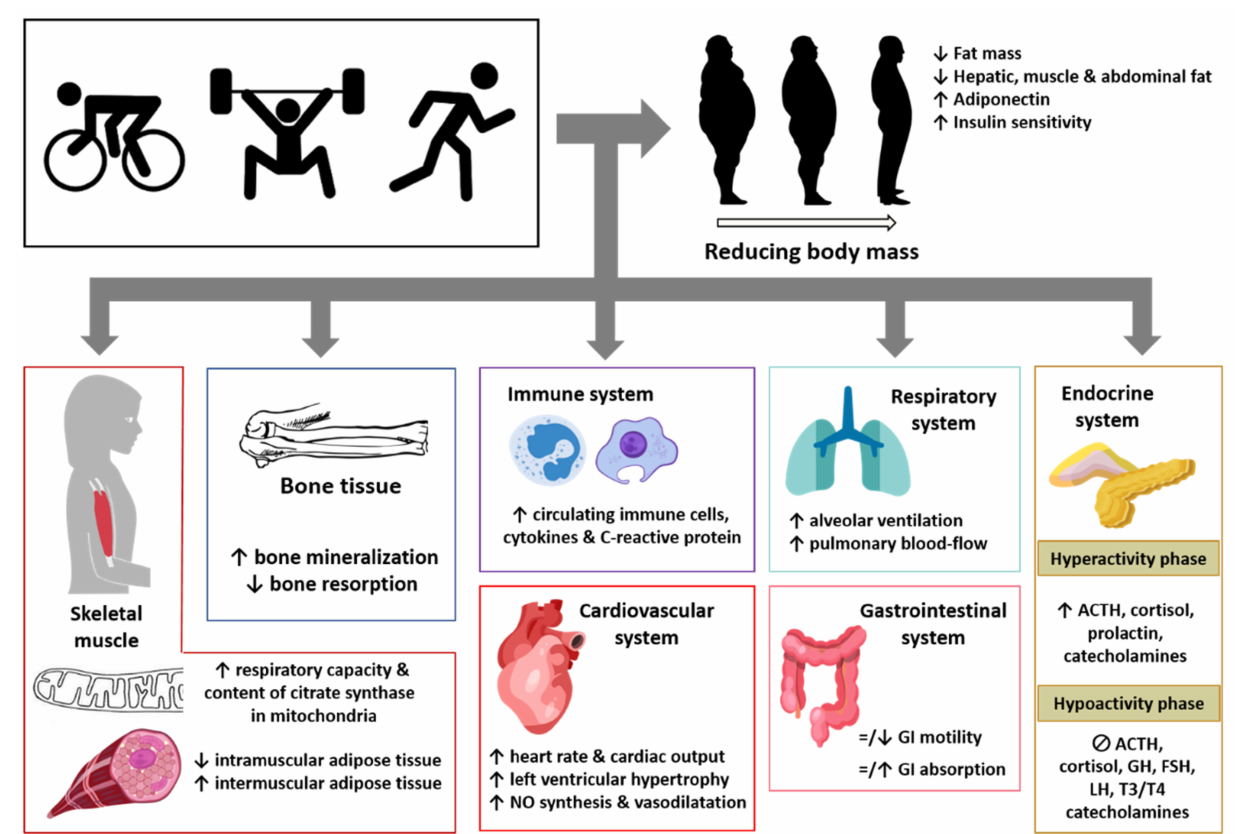
Figure 3. Overall vision of the effect of physical exercise on body tissues and systems. Physical exercise causes a reduction in body mass with a direct impact on the reduction of accumulated fat, which facilitates an increase in the secretion of adipokines that favor tissue insulin sensitivity in obese subjects. Likewise, physical exercise also has a direct impact on various organs and body systems. On skeletal muscle, it causes metabolic changes especially in mitochondrial physiology, increasing respiratory capacity and the content of Krebs cycle enzymes (e.g., citrate synthase). It also causes a decrease in intracellular lipids, favoring adipose tissue to accumulate mainly at the extracellular level, that is, between skeletal muscle fibers (intermuscular adipose tissue). In bone tissue, physical exercise favors mineralization and therefore reduces bone resorption. At the level of the immune system, physical exercise favors an increase in immune cells in the bloodstream, but also in cytokines and proteins of the acute inflammatory phase (e.g.,). In the cardiovascular system, physical exercise improves various cardiac parameters, and favors the release of diffusible factors that induce vasodilation. On the respiratory– pulmonary system, physical exercise increases alveolar ventilation and pulmonary blood flow. The impact of physical exercise on the gastrointestinal system is dependent on the intensity of this physical exercise. At low or moderate intensities, there are no changes (=) neither in motility nor in gastrointestinal absorption, while with intense physical activity there is a decrease in motility and an increase in gastrointestinal absorption. The endocrine system is also influenced by physical exercise. During the hyperactivity phase, an increase in the levels of various hormones is observed, which suggests that various hormonal axes are highly activated in this hyperactivity phase. On the contrary, in the phase of hypoactivity, the secretion of many hormones is interrupted. For details, see the main text. Source for figure illustrations: https://scidraw.io/ (accessed on 8 September